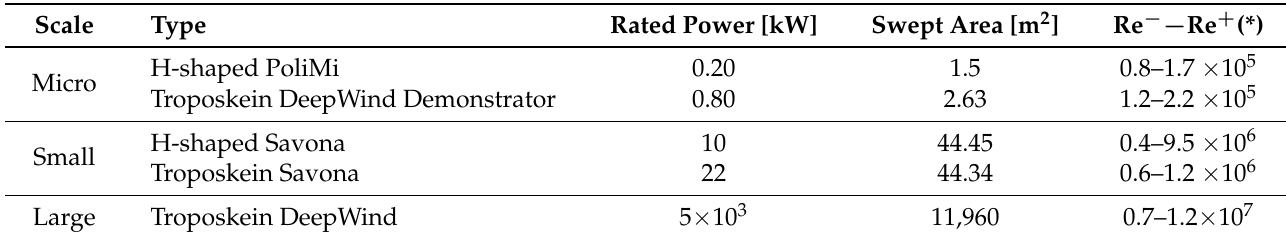
Table 5. List of study cases. (*) Maximum and minimum Reynolds number are referred to optimal TSRs, at equatorial plane. Scale